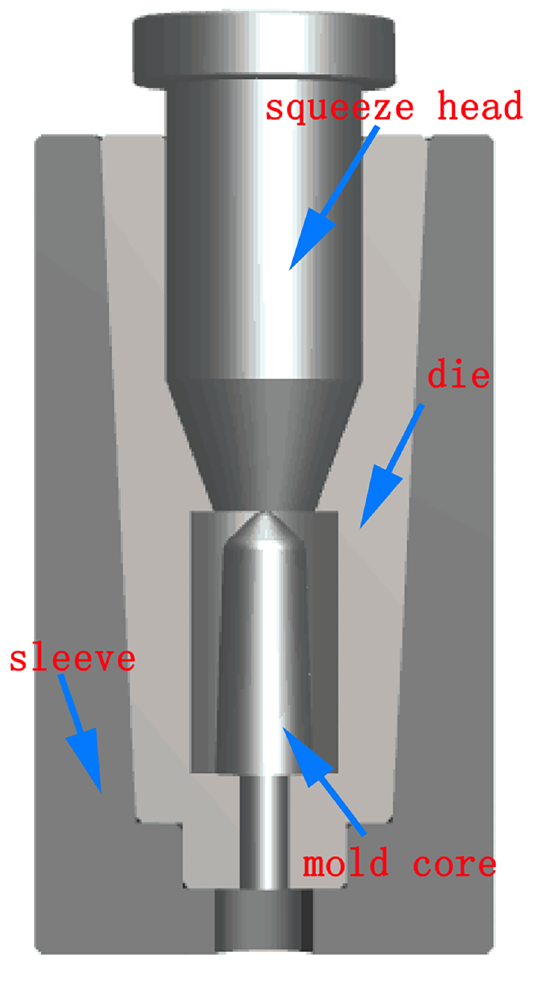
Figure 1. Punch and die